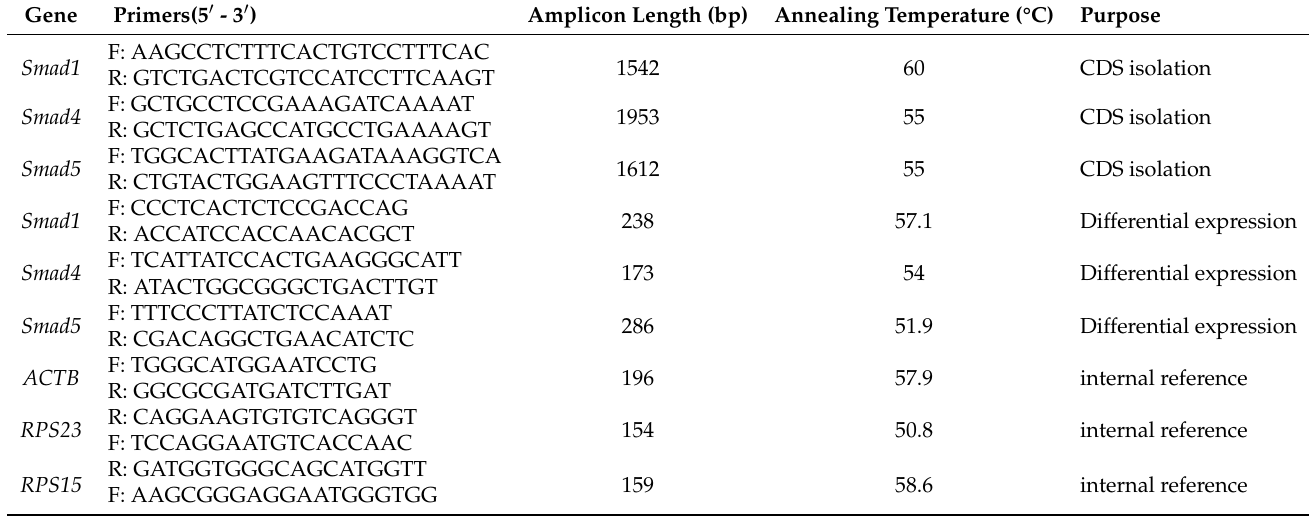
Table 1. Primers used for isolating buffalo Smad1 , Smad4 , and Smad5